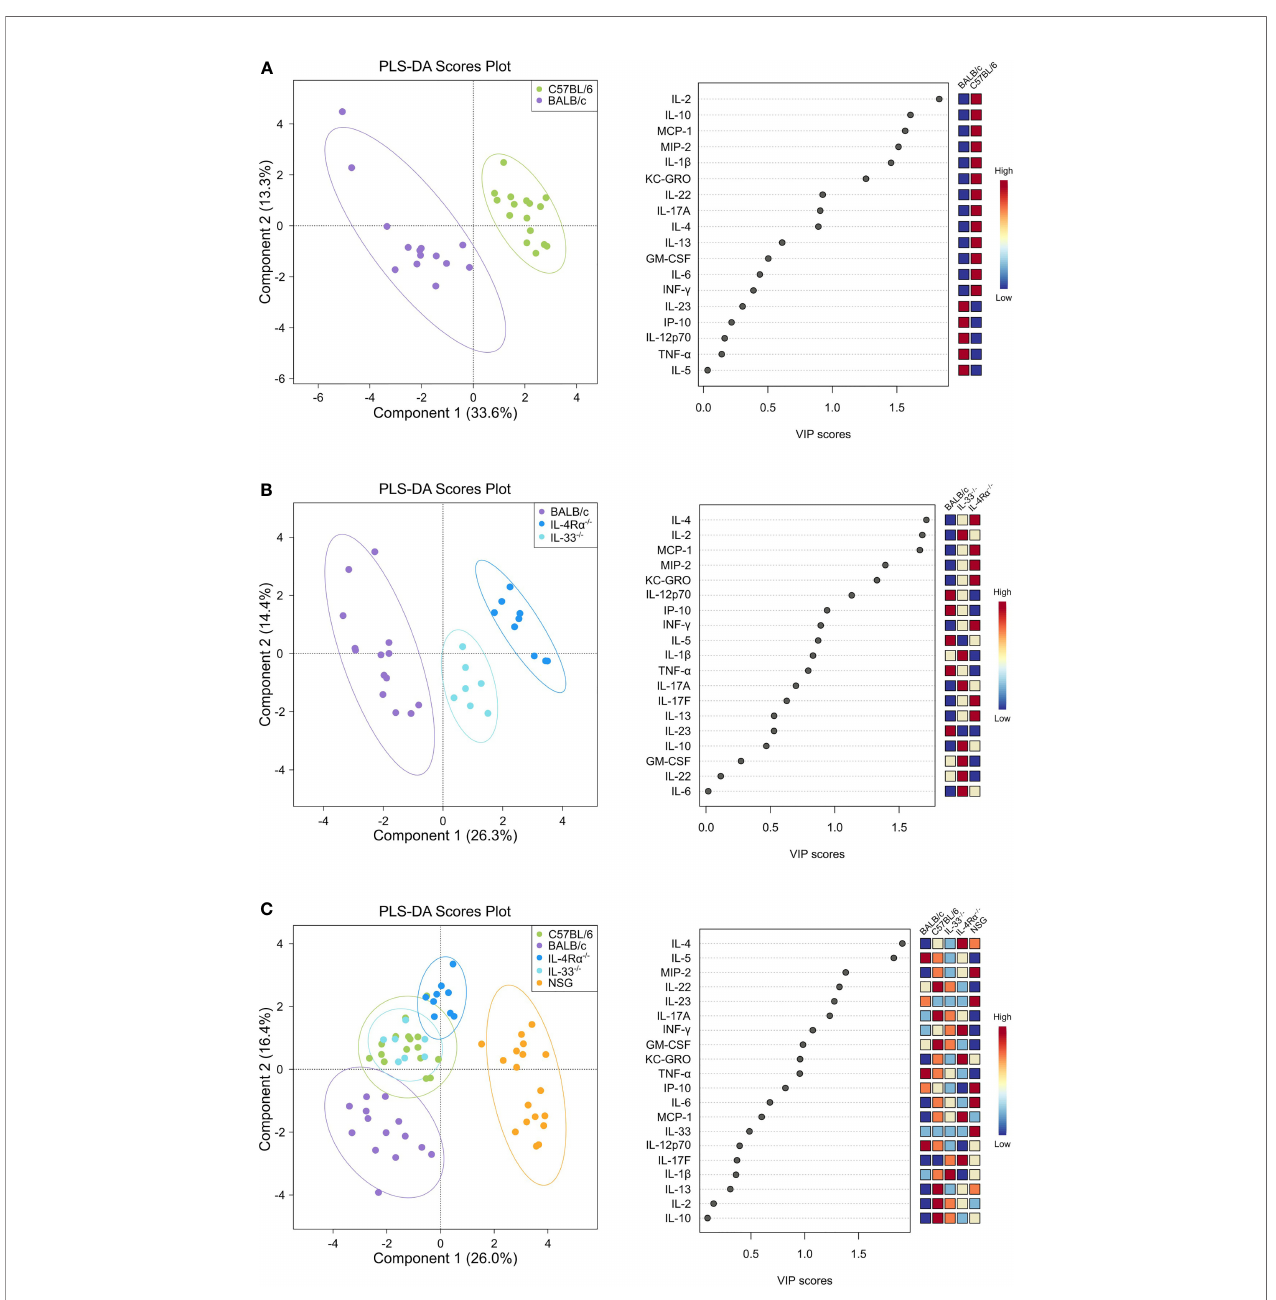
FIGURE 1 | Discriminant analysis reveals distinct cytokine, chemokine, and growth factor (CCG) pro fi les in naïve wild-type, Th2-de fi cient, and Th1/Th2- de fi cient animals. Plasma CCG levels were measured with multiplexed assays in SPF-housed wild-type C57BL/6 (n = 16, green) and BALB/c (n = 14, purple), Th2-de fi cient BALB/c IL-4R a -/- (n = 9, blue) and IL-33 -/- (n = 7, light blue), and Th1/Th2-de fi cient NSG (n = 18, orange) animals and analyzed with partial least squares discriminant analysis (PLS-DA). Two-component plots on the left visualize the differences between genotypes whereas variable importance (VIP) scores are visualized with dot plots and indicate the contribution of each CCG with the contribution of individual genotypes displayed as a heatmap on the right. (A) C57BL/6 and BALB/c wild-type mice were compared, showing a clear separation in cytokine pro fi les that was mostly attributed to cytokines IL-2, IL-10, MCP-1, MIP-2, and IL-1 b as indicated by the VIP scores. (B) Cytokine pro fi les of BALB/c wild-type, IL-4R a -/- , and IL-33 -/- mice were analyzed, showing notable differences between knock-out and wild-type mice, mostly due to IL-4, IL-2, and MCP-1, which were more pronounced in IL- 4R a -/- mice. (C) By comparing all genotypes, a clear distinction between NSG mice cytokines and all other studied genotypes was observed, where IL-4 and IL-5 constituted the major contributing factors. VIP, Variable importance in projection; CCG, cytokine chemokine and growth